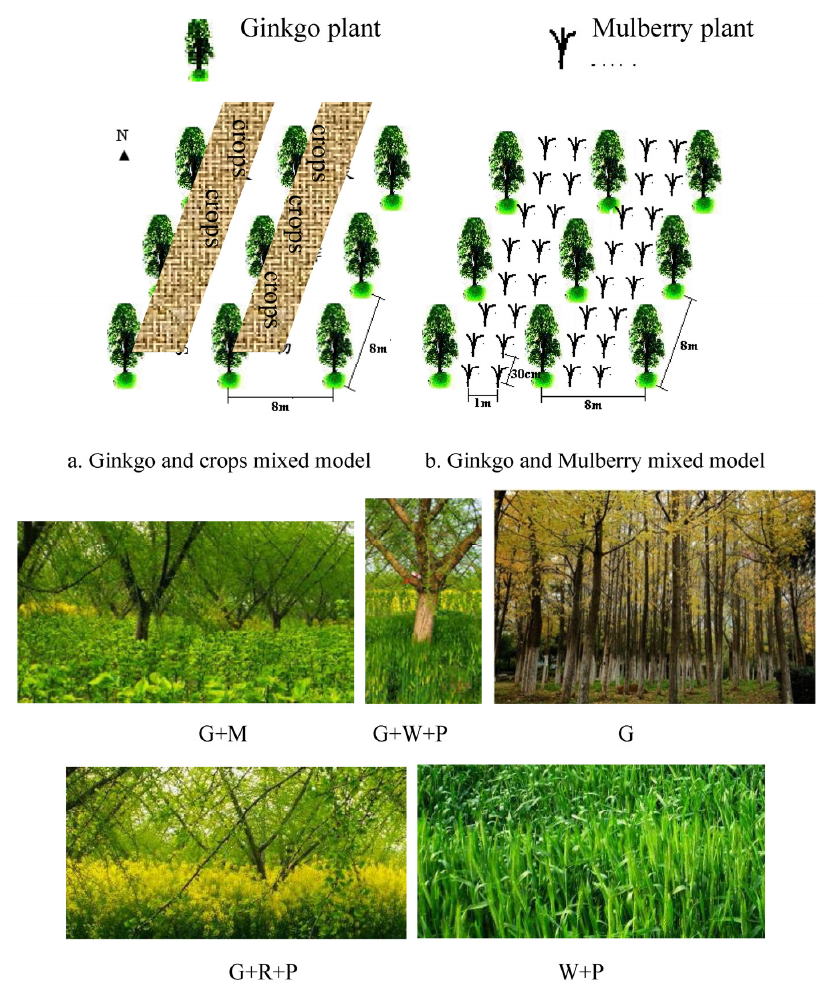
Figure 1. Planting structure for the experiment site, with ( a ) Gingko and crops mixed system, ( b ) Ginkgo and Mulberry mixed system. Pictures shows the five Ginkgo experimental systems: Ginkgo ‐ Mulberry (G+M); Ginkgo ‐ Wheat ‐ Peanut (G+W+P); Ginkgo ‐ Rapeseed ‐ Peanut (G+R+P); Ginkgo (G); and Wheat ‐ Peanut (W+P).